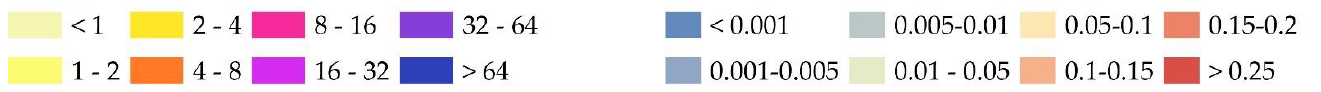
Figure 5. Modeled wildfire exposure to communities in terms of the number of exposed structures per year ( A ) and exposure ratio ( B ) relative to the total number of structures within the community in Portugal. The total number of structures exposed to wildfires, including residential housing, industrial, agricultural, and other facilities, is 10,394 per year. The maps are colored by freguesia neighborhoods within communities or concelhos.